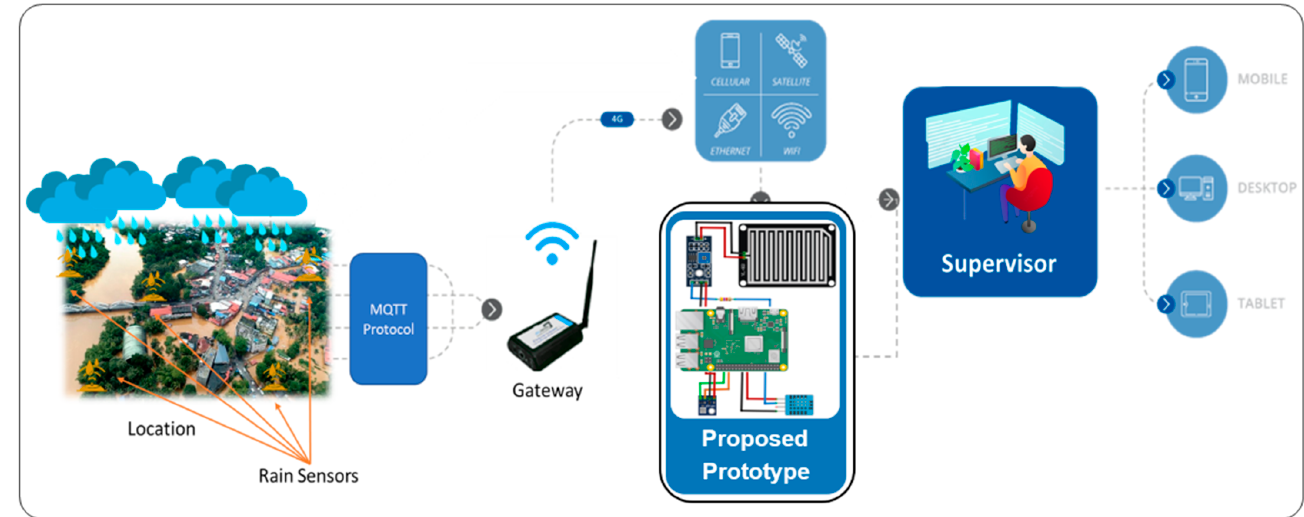
Figure 11. A flow diagram for the proposed prototype.